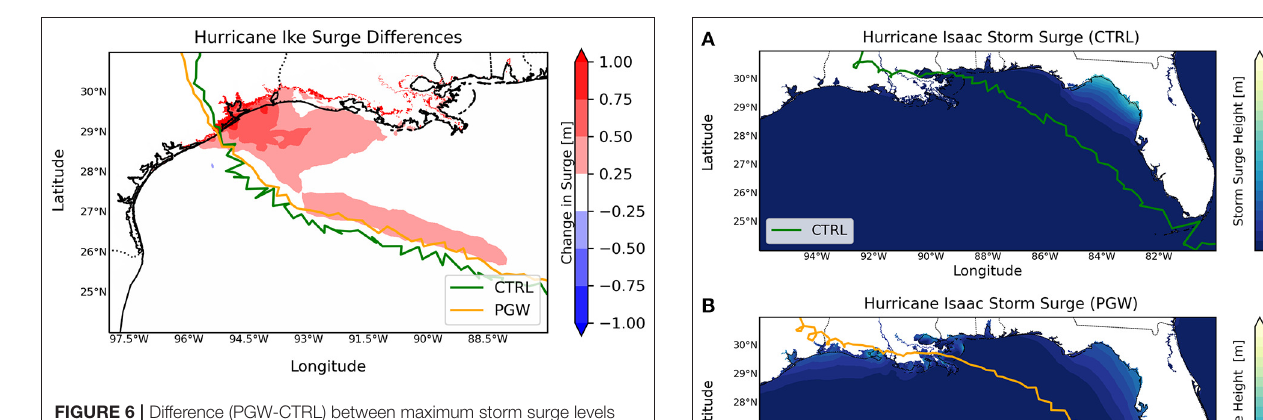
FIGURE 6 | Difference (PGW-CTRL) between maximum storm surge levels over the 21st century for Hurricane Ike. The storm tracks for the CTRL (green) and PGW (orange) simulations are also included.